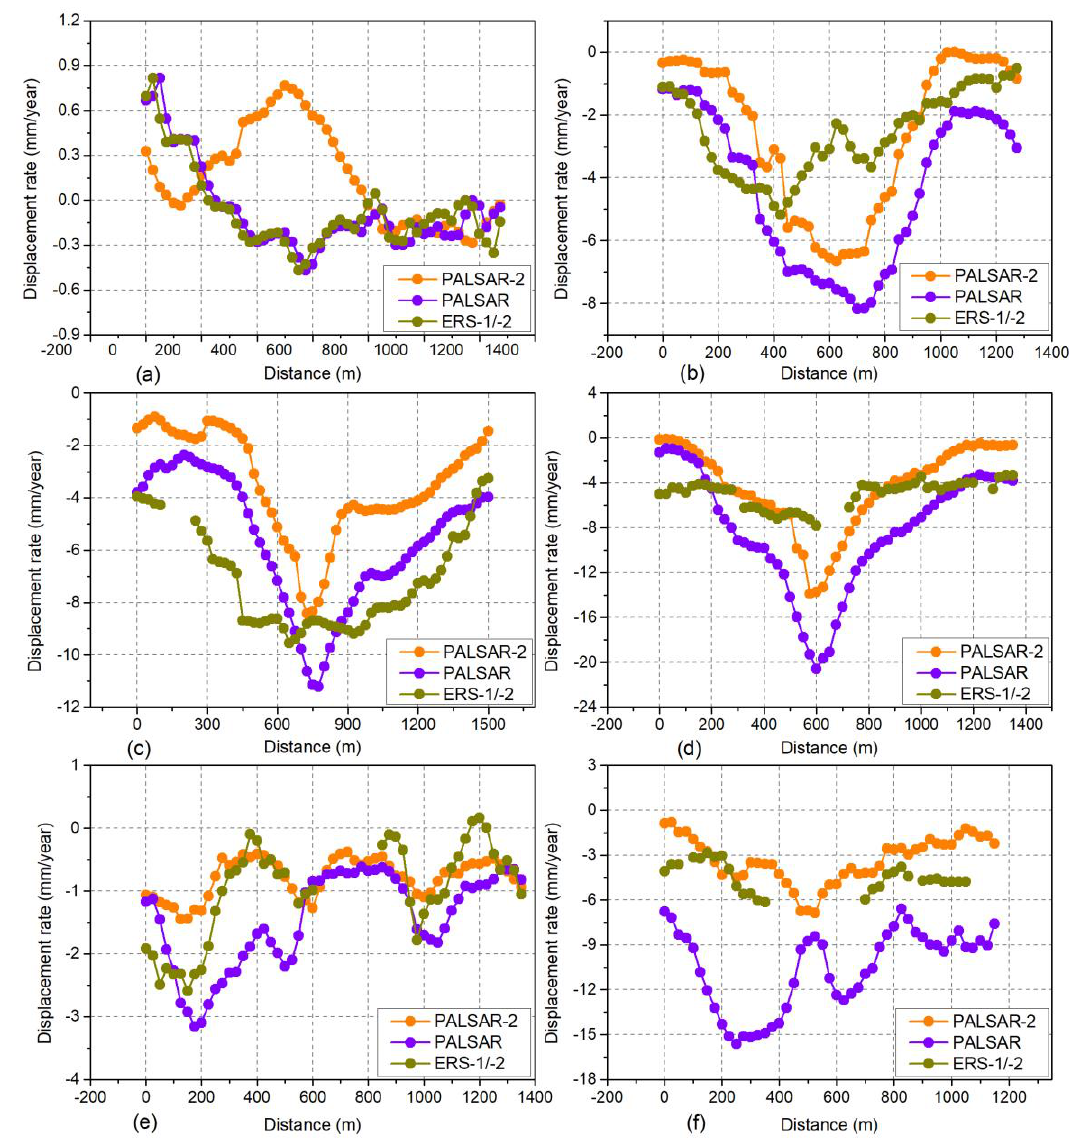
Figure 11. Mean LOS displacement velocities for the three observation periods ( a – f ) along the six profiles whose positions are indicated as purple lines in Figure 9.